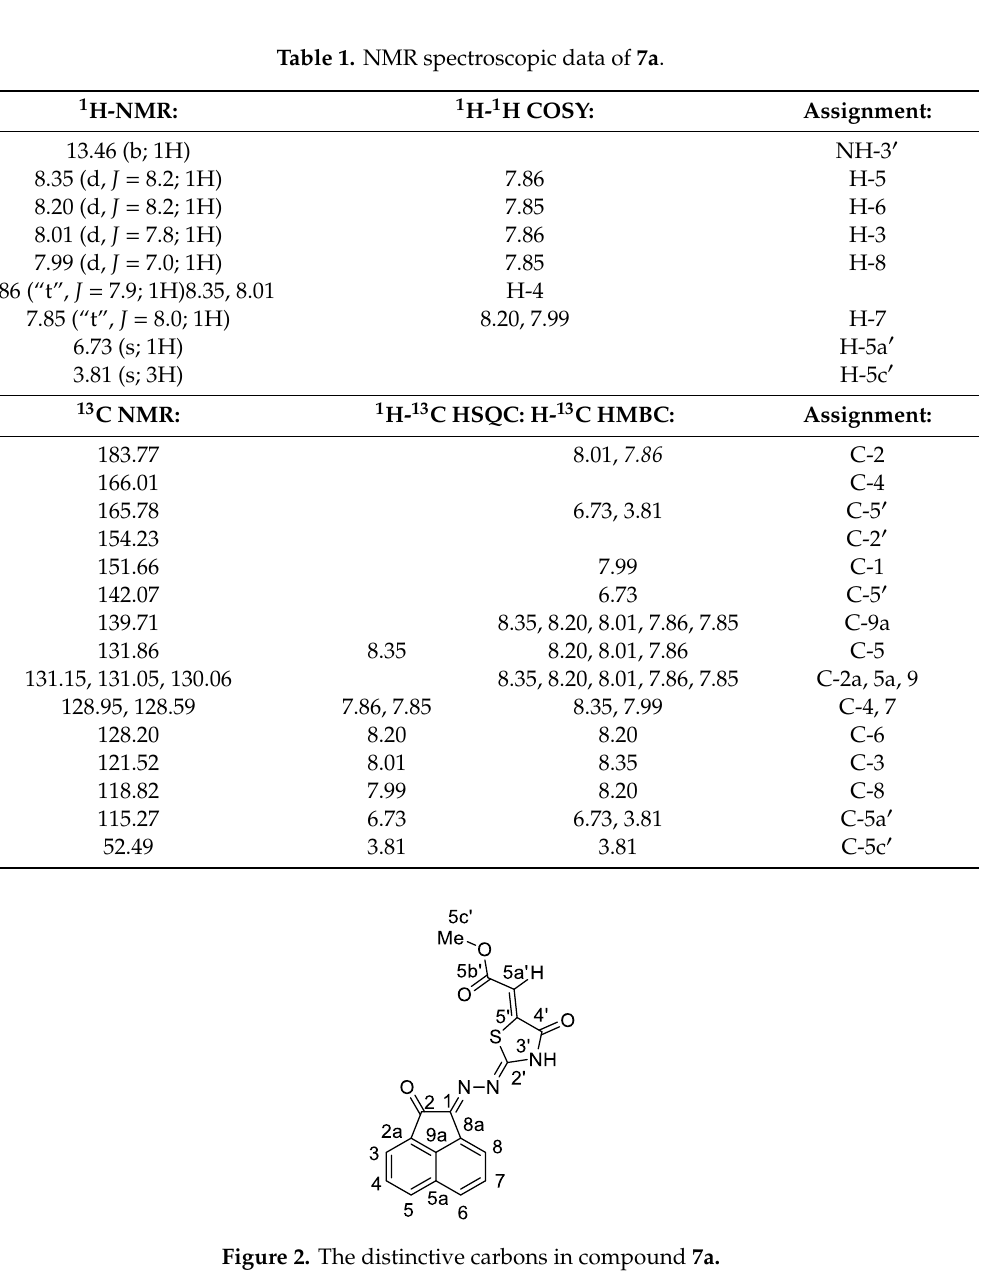
Table 1. NMR spectroscopic data of 7a .